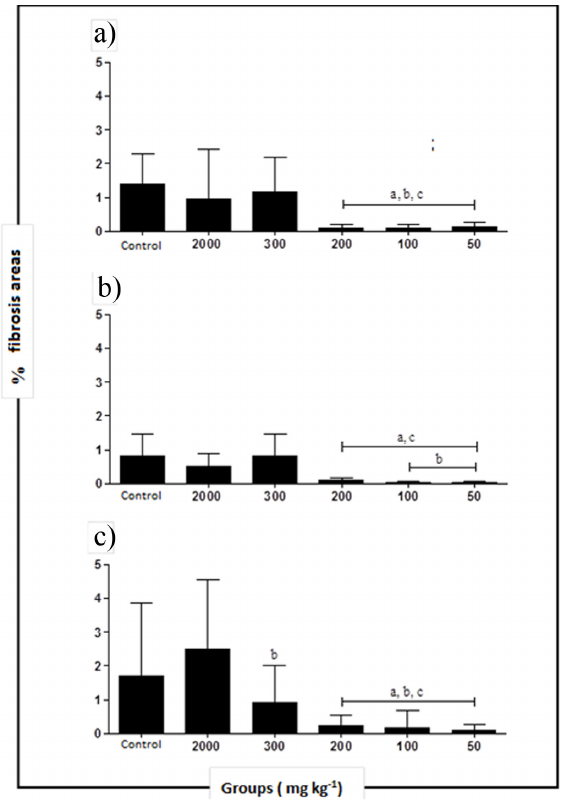
Figure 10. Percentage quantification of area of fibrosis in different organs of mdx mice treated with different doses of aqueous extract from leaves of Miconia ferruginata . a) Liver tissue; b) Lung tissue; c) Tibialis anterior muscle tissue. ANOVA, Dunn’s post hoc test, p <0.001. a: statistically significant difference in comparison to control group; b: statistically significant difference in comparison to 2000 mg kg -1 dose group; c: statistically significant difference in comparison to 300 mg kg -1 dose